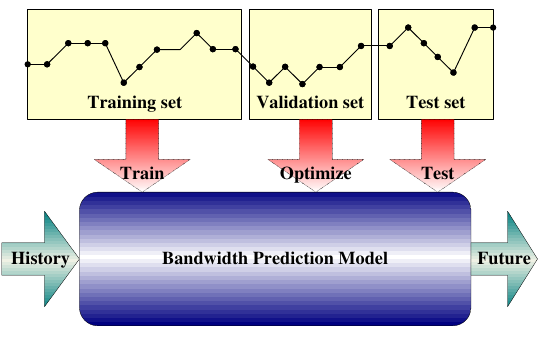
Fig. 1. Prediction